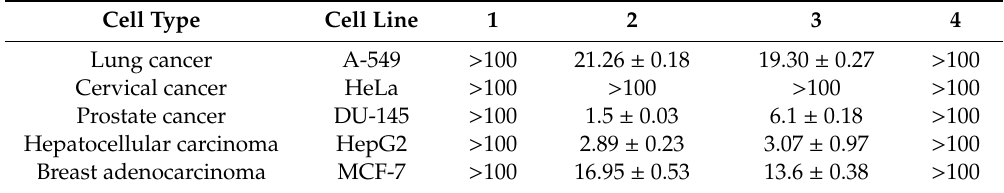
Table 2. Cytotoxic activities of compounds 1 – 4 in µ M against five selected human solid tumor cell lines ( n = 3).